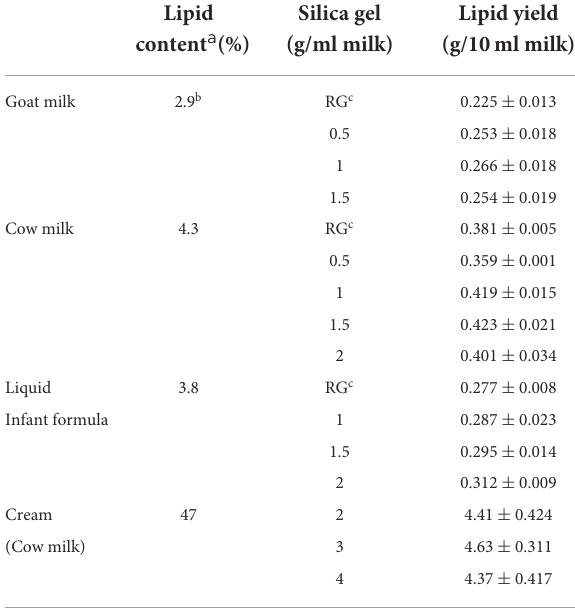
TABLE 1 Effect of the amount of silica gel on lipid